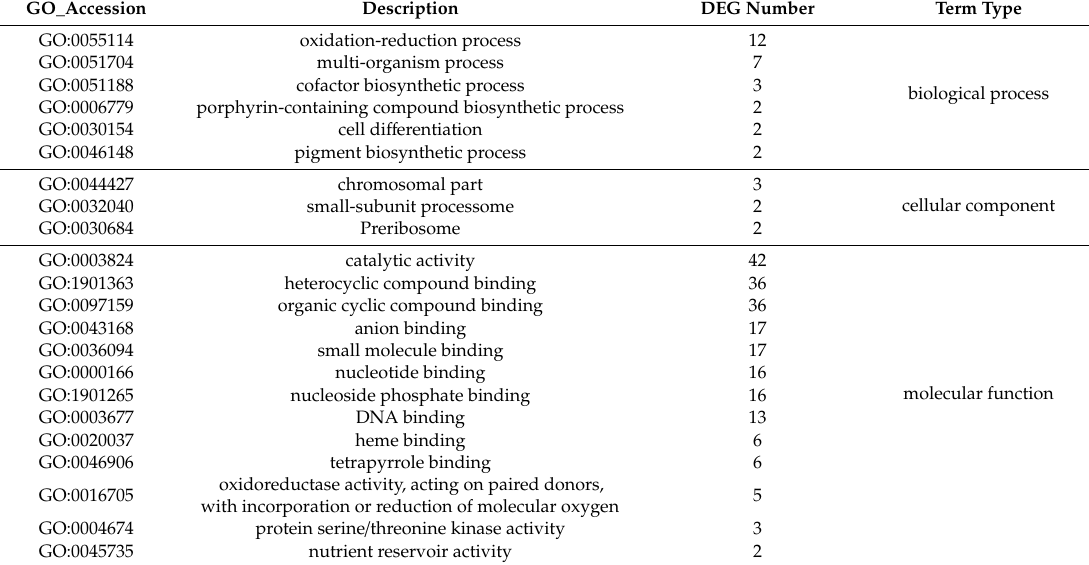
Table 1. Gene ontology (GO) enrichments of upregulated genes.